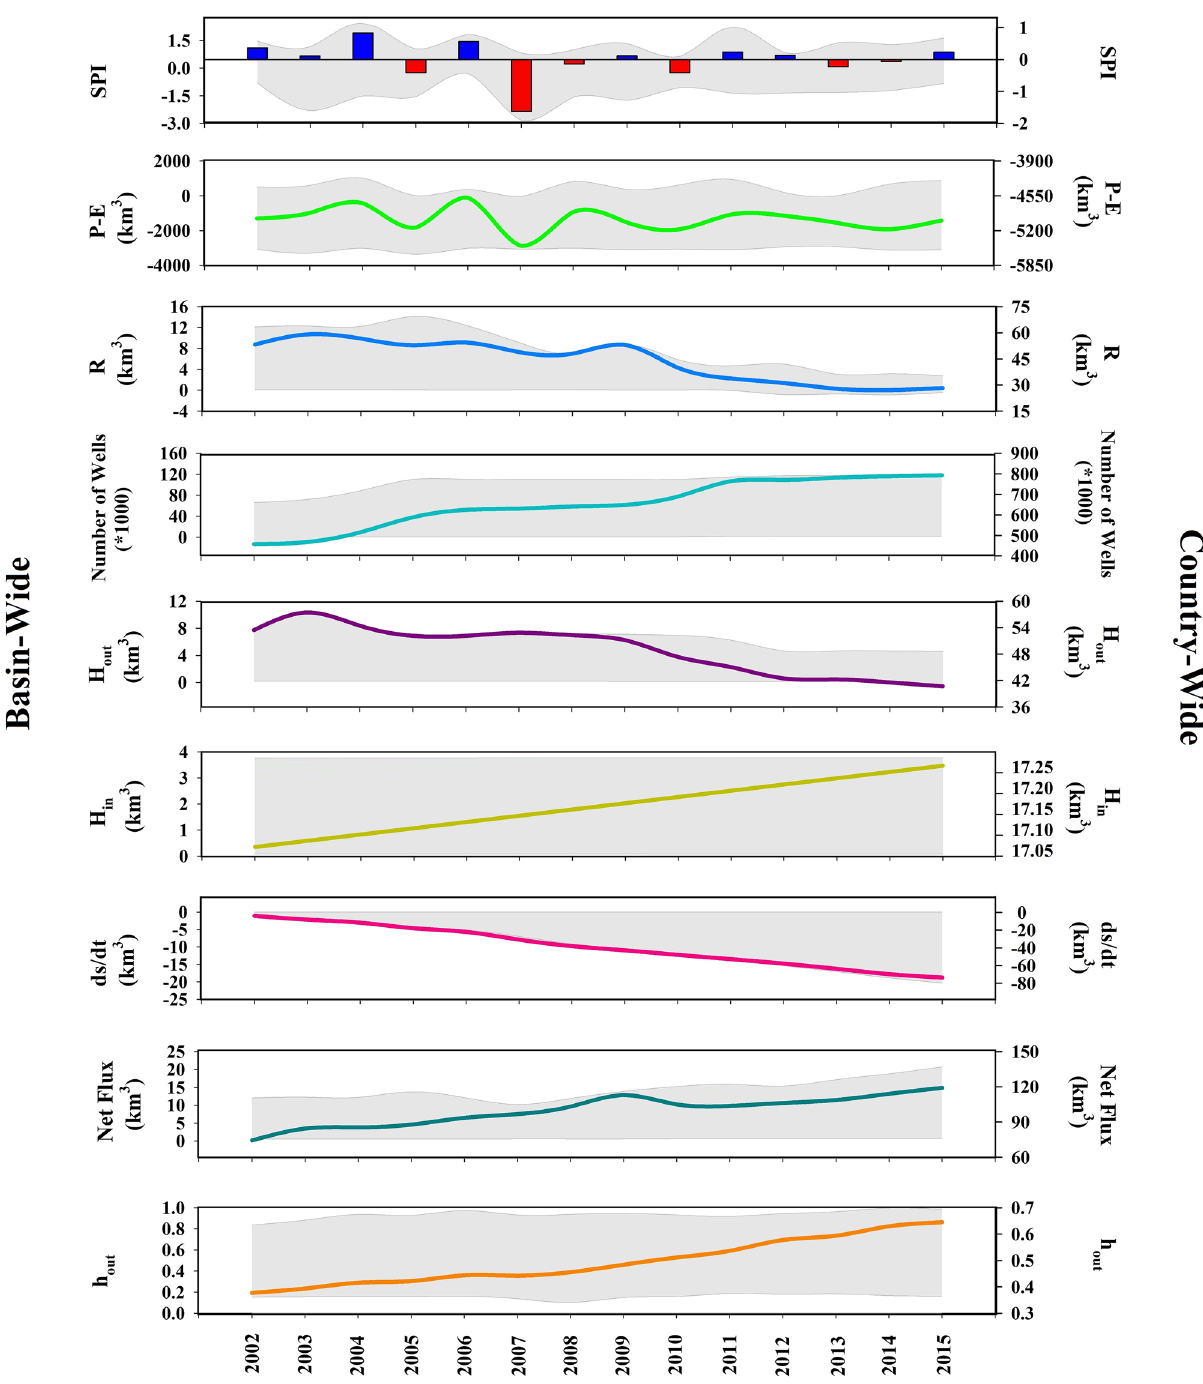
Figure 2. Evolution in groundwater storage ( ds/dt ) and its corresponding natural and anthropogenic drivers during 2002–2015 at the country (right y-axis) and basin scales (left y-axis). SPI is Standard Precipitation Index; P − E is precipitation minus pan evaporation; R is recharge, H out is human outflow, H in is human inflow, R + H in -ds/dt is the net outgoing flux and h out is the normalized human outflow. Country- and basin-wide dynamics in each variable are shown by solid lines and gray envelope, respectively (This figure is created using